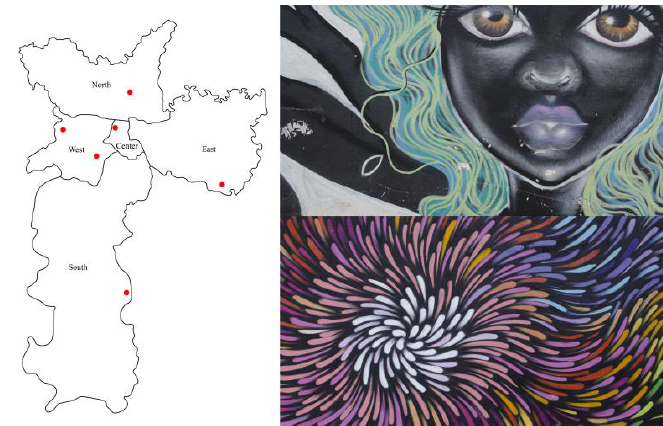
Figure 1. Left : red dots indicate the areas within the five zones of the city of São Paulo where the photos of the graffiti were taken. In total, 228 photos were analyzed in the study: 26 from the north, 59 from the south, 44 from the east, 44 from the west, and 55 from the center. The areas were chosen to represent the diversity of styles and selected under the advice of local recognized graffiti artists . Right : two examples of graffiti in our sample.